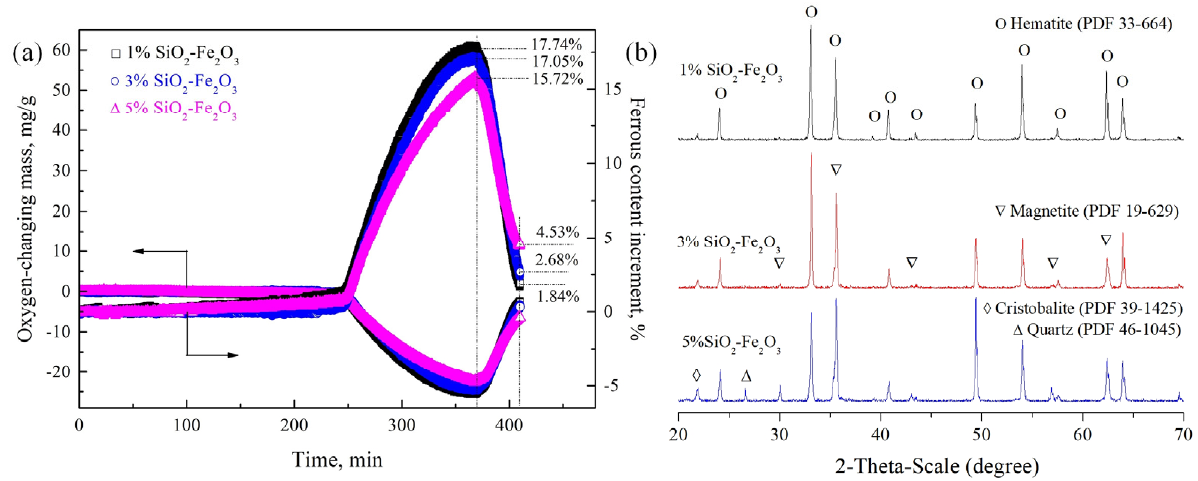
Figure 9. Effect of SiO 2 content on the ferrous content in the temperature-changing process from Stage 4 to Stage 9 ( a ) and XRD patterns of samples at Stage 9 ( b ). The contents of magnetite at Stage 4, Stage 8 and Stage 9 and the SH at Stage 9 calculated by the ferrous content are listed in Table 1. The contents of SH decreased from 68.14% to 61.59% and 47.96%, respectively, with the increase in SiO 2 content from 1.0%, 3.0% to 5.0%, respectively; while they increased from 70.08% to 72.14% and 74.27%, respectively, with the increase in Al 2 O 3 content from 1.0%, 3.0% to 5.0%, respectively, where it is supposed that Al 2 O 3 was uniformly distributed into iron oxides. Table 1. Contents of magnetite at Stage 4, Stages 8 and 9 and SH at Stage 9. Stage Minerals